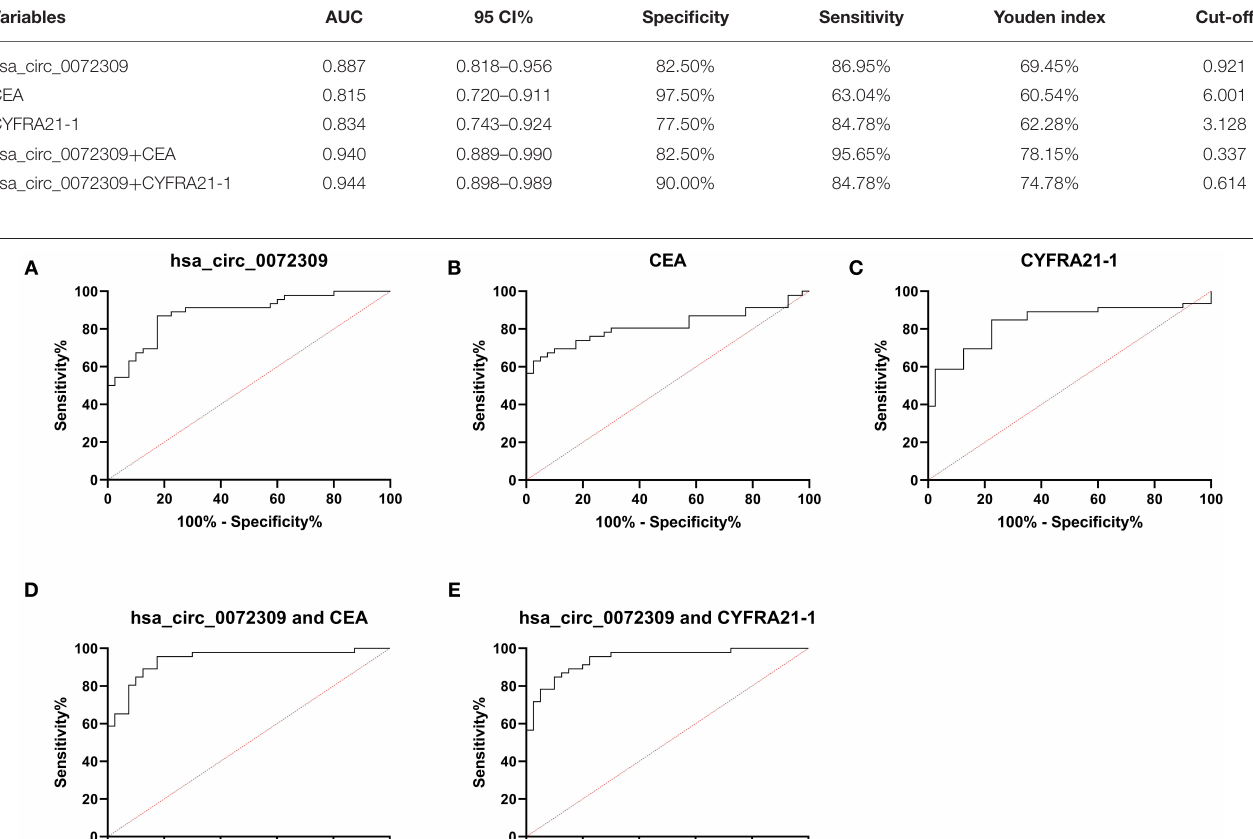
TABLE 4 | ROC curve parameters.